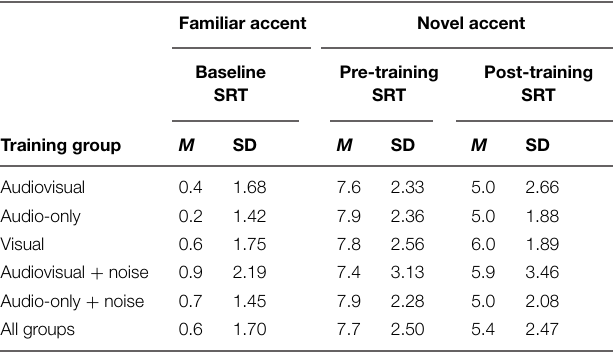
TABLE 2 | Mean SRTs in dB per training group (Study